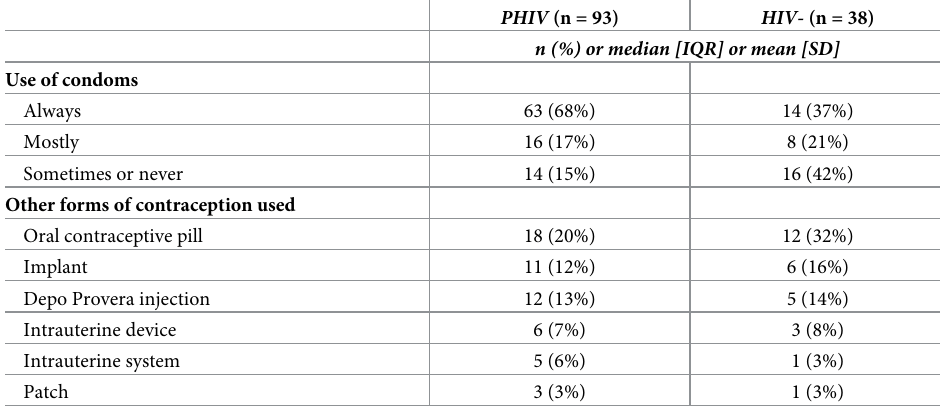
Table 3. Contraception use of PHIV and HIV- participants who were sexually